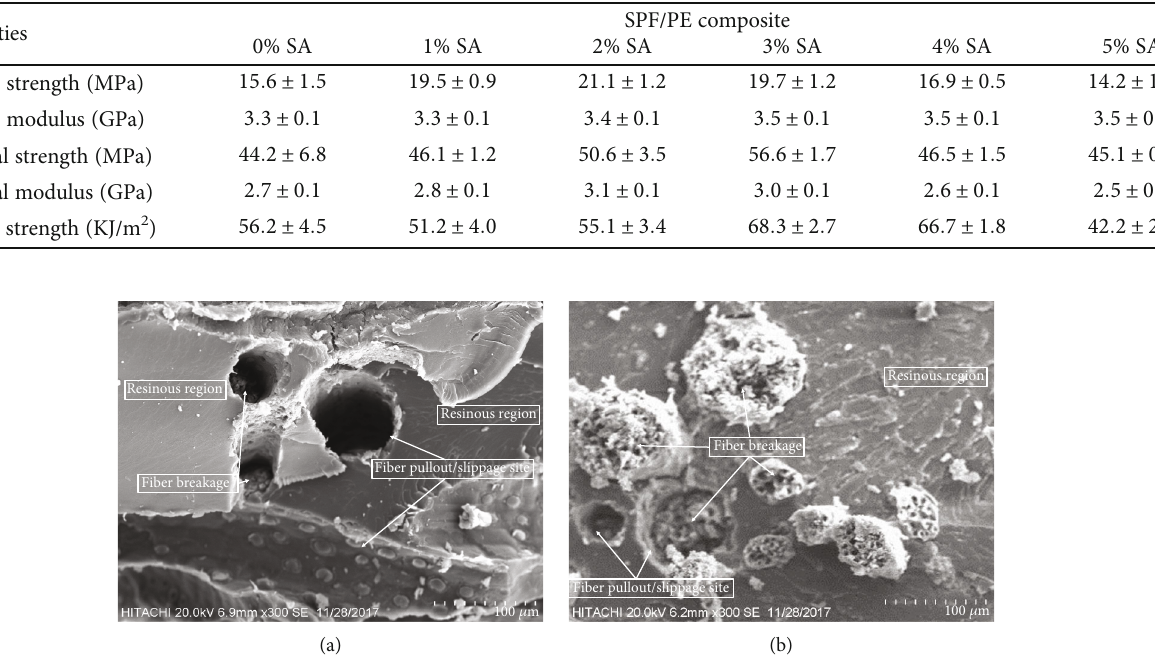
Figure 2: SEM images of SPF/PE (a) 0% SA composite and (b) 3% SA-infused